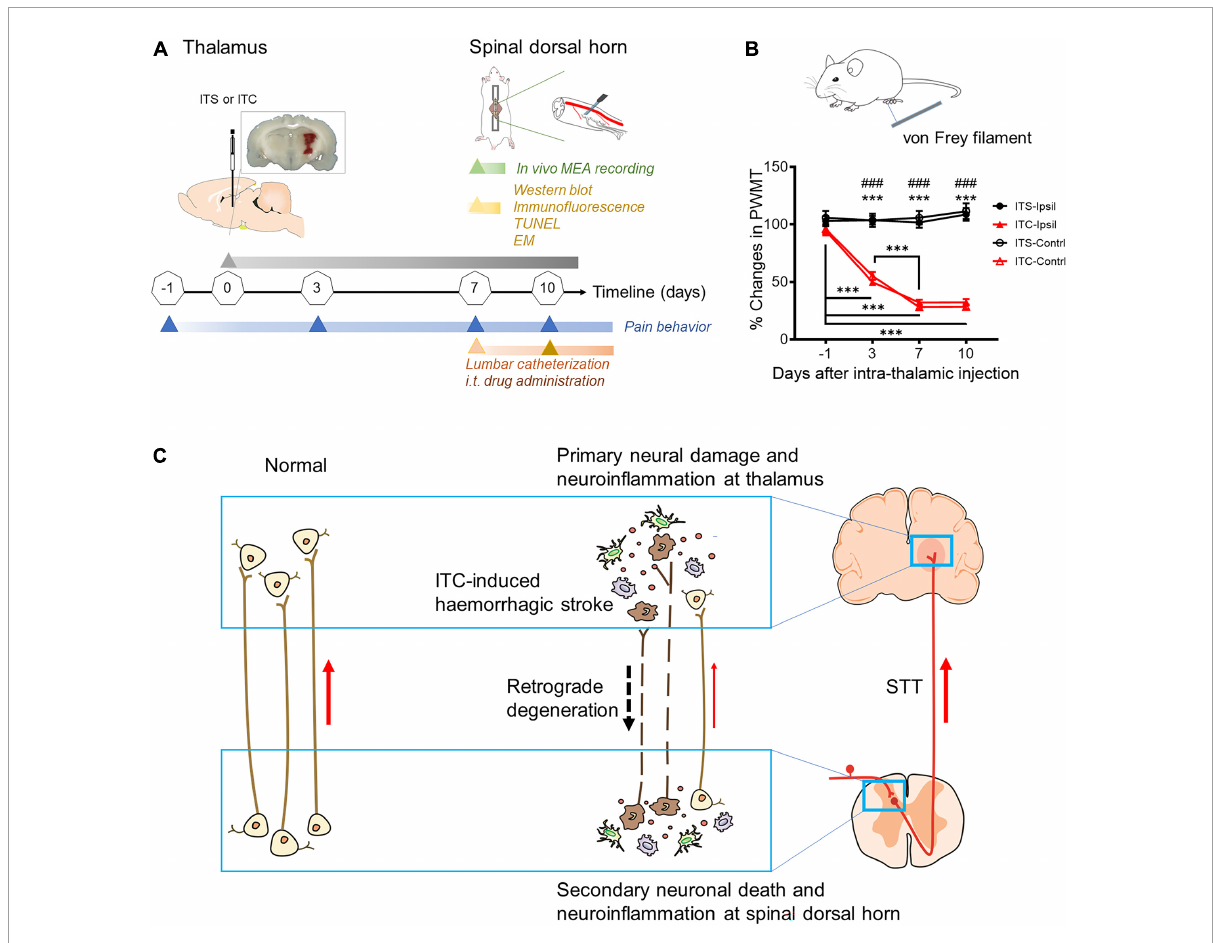
FIGURE1 Diagram of experimental timeline and hypothesis of this study. (A) Experimental timelines. EM, electron microscopy; i.t, intrathecal; ITC, intra-thalamic collagenase IV injection; ITS, intra-thalamic saline injection; MEA, multi-electrode array; TUNEL, terminal deoxynucleotidyl transferase-mediated nick end labeling; (B) time courses of bilateral mechanical pain hypersensitivity induced by left ITC with ITS as control. Contrl, contralateral; Ipsil, ipsilateral; PWMT, paw withdrawal mechanical threshold; *** p < 0.001 Day 3, Day 7, Day 10 vs. one day prior to surgery; ### p < 0.001 ITC-Ipsil vs. ITS-Ipsil; *** p < 0.001 ITC-Contrl vs. ITS-Contrl; n = 44 rats for ITS, n = 59 rats for ITC. (C) Hypothetic scheme proposes that post-thalamic hemorrhagic stroke (THS) pain hypersensitivity should be mediated by the THS-induced secondary neural damage and neuroinflammation in the spinal dorsal horn through retrograde axonal